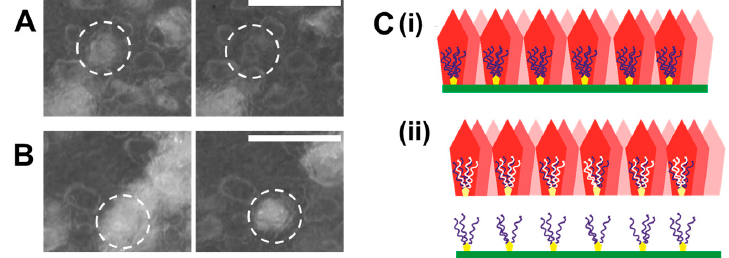
Figure 3. ( A , B ) Representative images of the hydration process of egg membranes with mammillae sites indicated by dotted circles shown before ( left ) and after ( right ) swelling. Scale bars represent 100 μ m. ( C ) Cartoon representation of the egg shell with the mineral (red), collagenous membrane (green), mammillae (yellow) and scaffold-bound hydrogel-like macromolecules (indigo) shown ( i ) before and ( ii ) after decalcification.